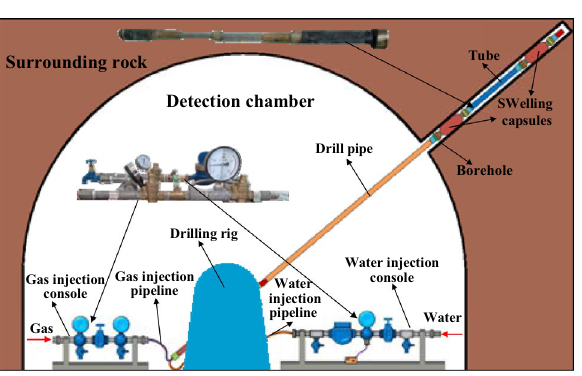
Figure 7. Layout of detection system (This figure is drawn by the Microsoft office 2016, https:// www. micro soft. com/ zh- cn/ micro soft- 365/ previ ous- versi ons/ micro soft- office-